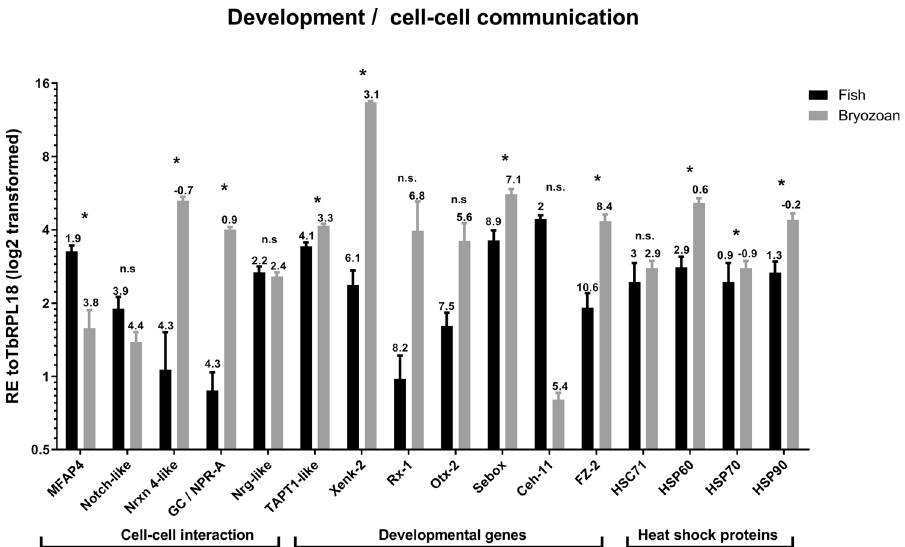
Figure 7. Average relative gene expression in infected bryozoan and infected fish kidney tissues of representative T. bryosalmonae genes involved in development and cell–cell communication. All gene values were normalized to Tb RPL18. Δ Cq values, stated above each bar, represent the expression level of genes of interest relative to Tb RPL18 in each infected host with values > 1 indicating lower expression and values < 1 indicating higher expression relative to Tb RPL18. * P < 0.05. Black bars = infected fish, grey bars = infected bryozoan. Gene abbreviations: microfibril-associated glycoprotein 4 (MFAP4), Notch-like protein (Notch- like), Neurexin 4-like (Nrxn 4-like), Guanylate cyclase A/atrial natriuretic peptide receptor A (GC/NPR-A), neuroglian-like protein (Nrg-like), Transmembrane anterior posterior transformation protein 1-like (TAPT1- like), Homeobox protein Xenk-2 (Xenk-2), retinal homeobox-1 (Rx-1), homeobox protein OTX2 (Otx-2), homeobox protein Sebox (Sebox), homeobox protein Ceh-11 (Ceh-11), Frizzled receptor-2 (FZ-2), heat shock protein 60 (HSP60), heat shock cognate 71 kDa protein (HSC71), heat shock protein 70 (HSP70) and heat shock protein 90